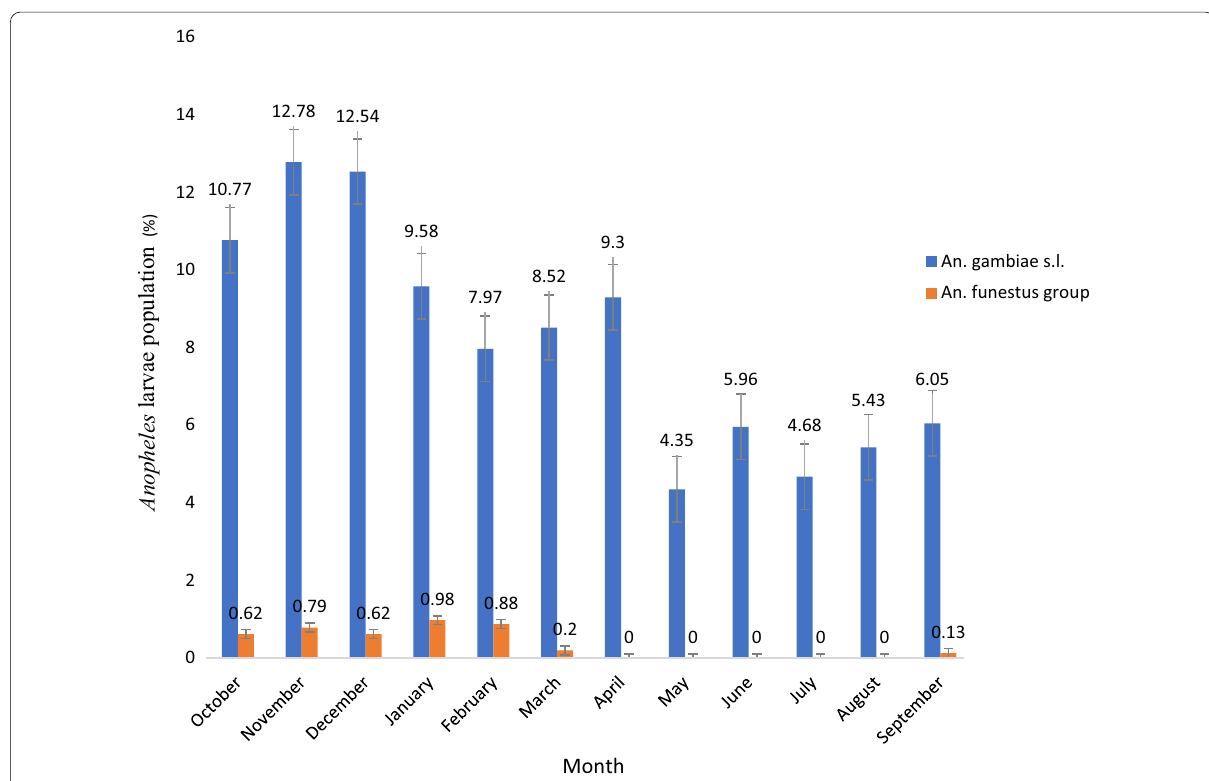
Fig. 2 Percentage monthly distribution of Anopheles larvae in the study area